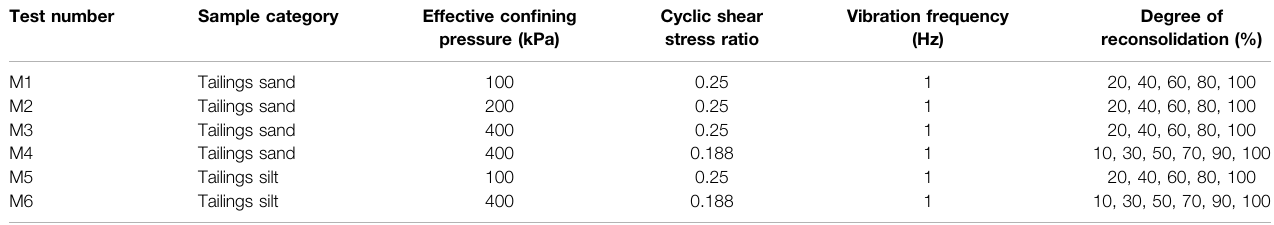
TABLE 3 | Test scheme for dynamic characteristics of lique fi ed tailings.